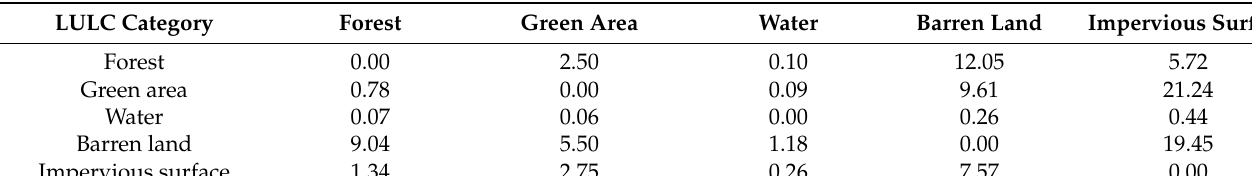
Table 5. Contribution of LULC categories to change 1990–2020 (%).